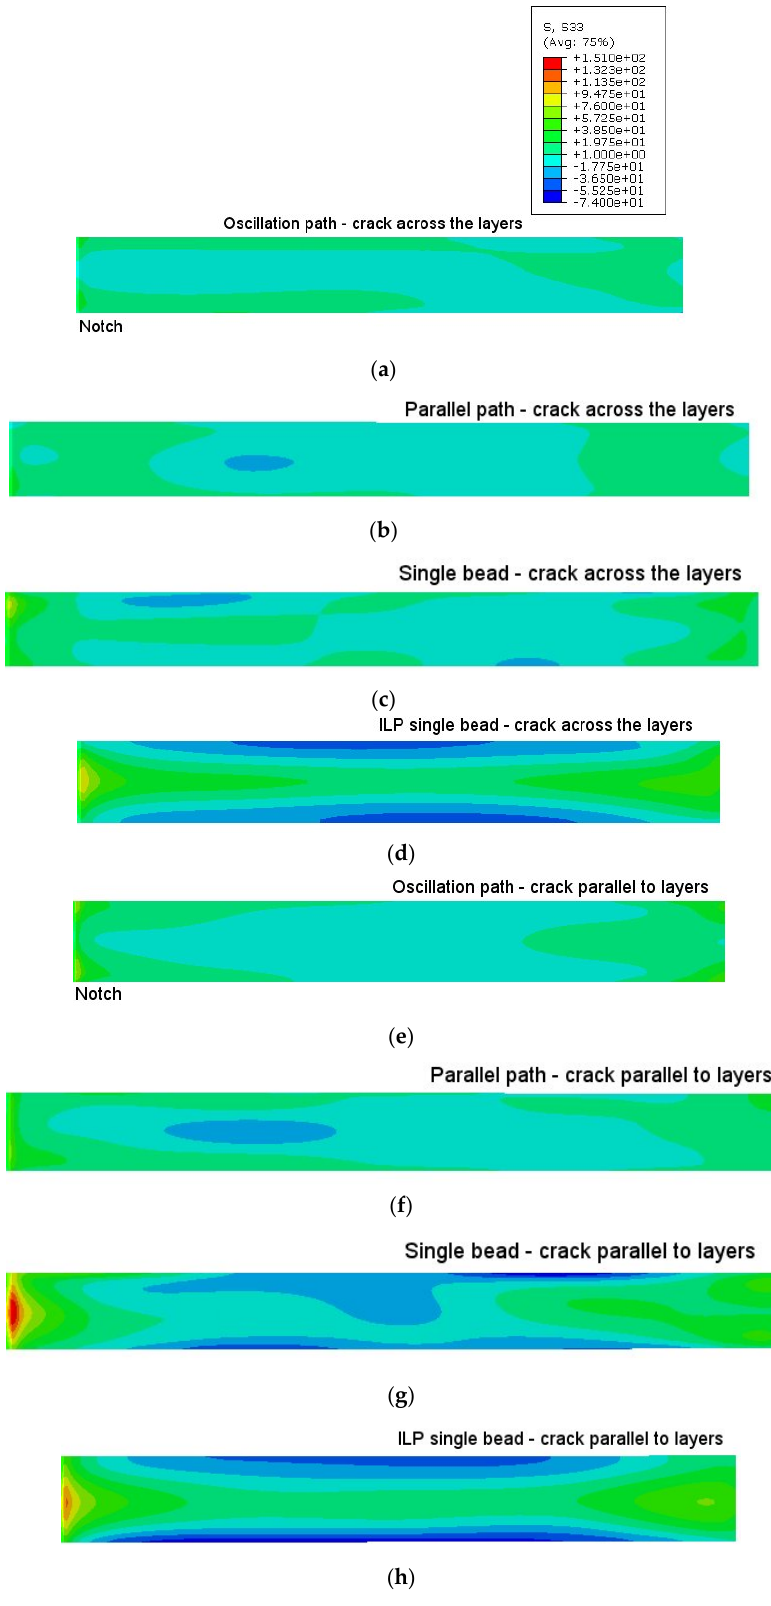
Figure 8. Residual stress results from the compact-tension (C(T)) coupons: ( a – d ) crack across the layers, ( e – h ) crack parallel to layers; in various build conditions as indicated. The through-thickness averaged residual stress profiles of all C(T) coupons (extracted from the oscillation path, parallel path, single bead, and ILP single bead walls) are compared in Figure 9. The unpeened single bead specimen showed the highest tensile residual stress at the notch root (about 110 MPa for the crack growth direction parallel to the build layers and 45 MPa for crack growth across the layers). The distance from the notch root where the tensile residual stress acts was about 5 mm for the coupon oriented for crack growth across the layers, and 7 mm for crack growth parallel to the layers. Lower tensile residual stress at the notch root was found in the case of coupons extracted from parallel pass and oscillation path walls (about 15 MPa for the crack growth direction across the layers and 45 MPa for the crack growth direction parallel to the layers). The C(T) coupon extracted from the parallel pass build wall showed different stress distribution along the crack path compared to other coupons for the same crack orientation. The ILP single bead coupons showed peak tensile residual stress at the notch root of 80 MPa for the crack growth direction parallel to the layers and 53 MPa for the crack growth direction across the layers. The tensile stress was present within the distance of 5 mm from the notch root.